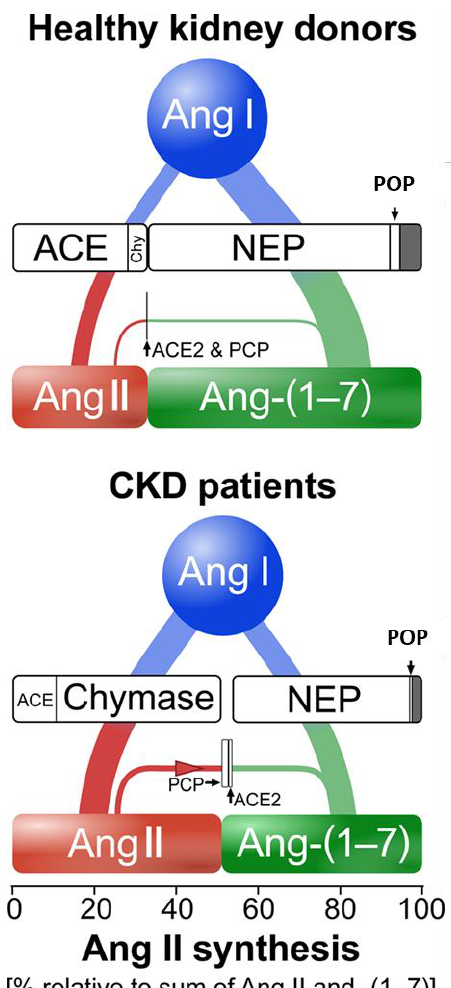
Figure 3. Overview of angiotensin processing by kidney-resident enzymes. Comparison of relative Ang (angiotensin) II and Ang (1–7) synthesis from Ang I in healthy kidney donors (top) and patients with chronic kidney disease (CKD; bottom). In healthy kidney donors, Ang I is mainly converted by NEP (neprilysin) to Ang (1–7) and to a smaller degree by ACE (angiotensin-converting enzyme) to Ang II. Minor contribution by chymase and POP (prolyl-endopeptidase) supplement Ang II and (1–7) synthesis, respectively. ACE2 and PCP (prolyl-carboxypeptidase)-mediated Ang II to Ang (1–7) conversion is present at a very low degree. Overall, the pathways producing Ang (1–7) exceed those which produce Ang II. B, In patients with CKD, Ang I is equally converted by chymase to Ang II and by NEP to Ang (1–7). Ang II synthesis is dominated by chymase and supplemented by ACE. POP-mediated Ang (1–7) synthesis is present at a very low degree. ACE2 and PCP-mediated Ang II to Ang (1–7) conversion is present at a higher degree than in healthy kidneys, albeit still minor in comparison to neprilysin’s activity. Thus, in comparison to healthy kidney donors, in patients with CKD severe renin–angiotensin system (RAS) dysregulation is exhibited, characterized by low Ang (1–7) production and high chymase-mediated Ang II production. In both cohorts, one or more unidentified enzymes contribute to a small portion of Ang I to Ang (1–7) conversion (depicted by gray area). The horizontal dimensions of the boxes equal median enzyme contribution [65].